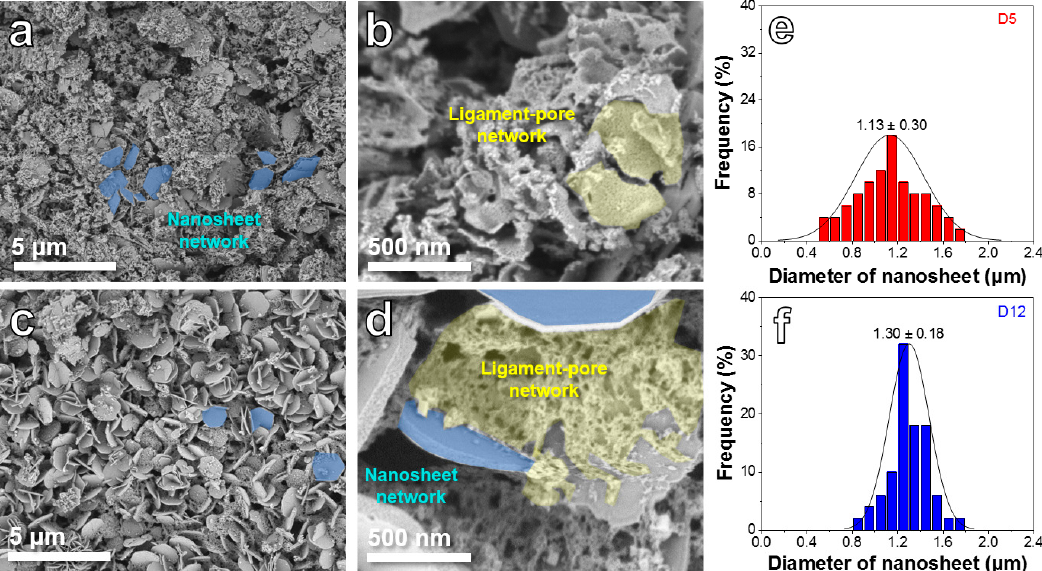
Figure 1. SEM images of D5 ( a , b ) and D12 ( c , d ). Nanosheet diameter distribution of D5 ( e ) and D12 ( f ). The microstructure of the D5 sample was analyzed in detail by TEM and high-reso- lution TEM (HRTEM). TEM images (Figure 2a–c) further demonstrate that the D5 sample was composed of nanosheet networks and ligament-pore networks. In addition, the liga- ment-pore network exhibits a typical feature of the bimodal porous structure with first- class pores of 50–150 nm and second-class pores of 3–5 nm (Figure 2a,b). The HRTEM image (Figure 2d) of the ligament-pore network shows the interplanar distance of 0.210 and 0.252 nm, which are consistent with the (2 0 0) planes of NiO and (3 1 1) planes of NiFe 2 O 4 , respectively [24,25]. In the meantime, as presented in the inset of Figure 2d, some obvious defects could be found at the lattice fringes by the inverse fast Fourier transform (IFFT). Specifically, in the (3 1 1) plane of NiFe 2 O 4 , the interplanar distance of the defect region was 0.255 nm, which is slightly higher than that of other normal regions and proves the existence of oxygen vacancies [26] in the lattice region of NiFe 2 O 4 . On the other hand, no obvious oxygen defects could be observed in the NiO region. Thus, the oxygen vacan- cies were proved to mainly come from NiFe 2 O 4 rather than NiO in this study. The selected area electron diffraction (SAED) pattern of the ligament-pore network (Figure 2e) was ob- tained as concentric diffraction rings, which are attributed to (3 1 1), (4 0 0), and (4 4 0) planes of NiFe 2 O 4 [27 – 29] and (2 0 0), (2 2 0) and (3 1 1) planes of NiO [24,30], suggesting a polycrystalline structure in the ligament-pore network. As shown in Figure 2f, the SAED pattern of the nanosheet is composed of some diffraction spots relating to (3 1 1), (1 3 − 1), and (4 4 0) planes of NiFe 2 O 4 with a matching zonal axis of [ − 1 1 2] [31]. This result indi- cates that the nanosheet is NiFe 2 O 4 single crystal.